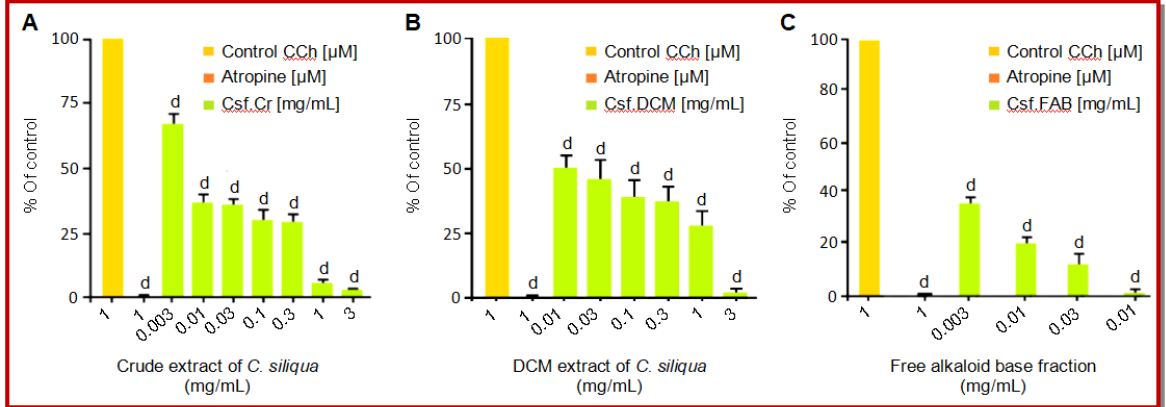
Figure 2: Inhibitory effect of (A) Crude extract of C. siliqua, (B) Dicloromethane (DCM) fraction of C. siliqua , (C) Free alkaloid base fraction of DCM fraction of C. siliqua on carbachol (1 uM)-induced contraction in segregated rabbit jejunum. n=5. a (p< 0.05), b (p< 0.01), c (p< 0.001), d (p< 0.0001) were considered statistically significant followed by One-Way-Analysis of variance (ANOVA). n=5